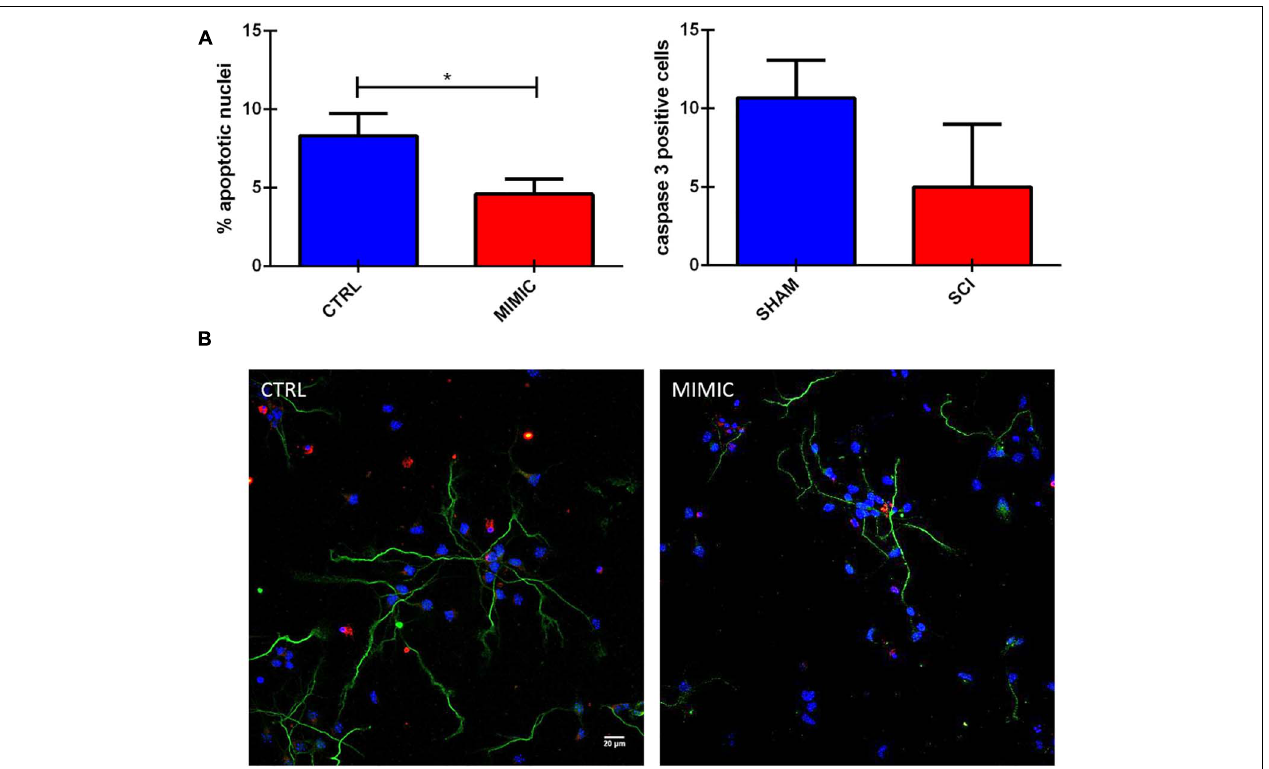
FIGURE 9 | miR-7b-3p reduces the number of apoptotic neurons in vitro . (A) Analysis of the percentage of apoptotic nuclei (% values ± SEM, t -test, * p = 0.03) and cleaved caspase 3 in mimic overexpressing cells. (B) Cleaved caspase 3 expression (red), SMI-32 (green), DAPI (blue) in CTRL and MIMIC cortical neurons.